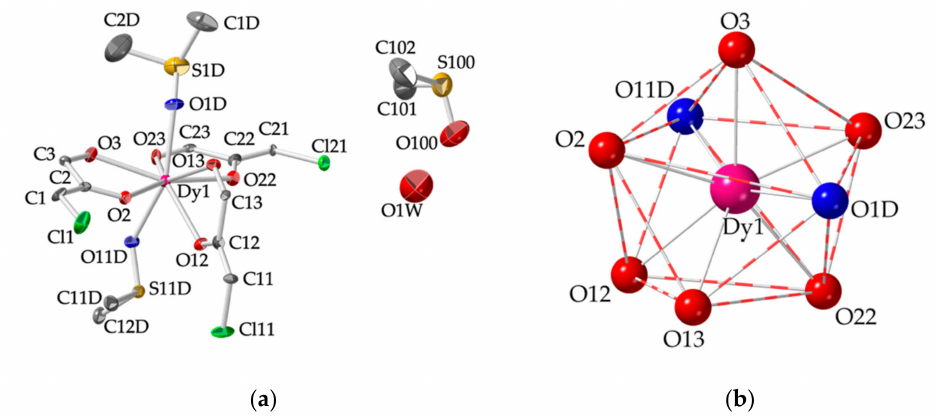
Figure 4. ( a ) Asymmetric unit of compound 2 with the labelling scheme (ellipsoids drawn at 50% probability). H atoms have been omitted for clarity; ( b ) Coordination environment of the Dy(III) ion in compound 2 . O atoms of the coordinated dmso are drawn in dark blue.